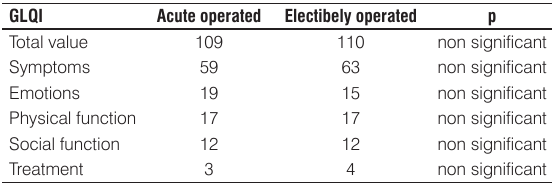
Table 4. Gastrointestinal Quality of Life Index by operated patients.